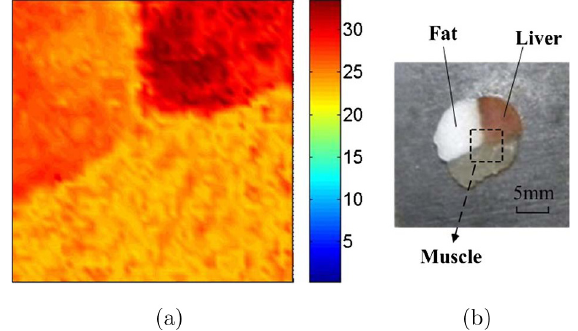
Source : Reproduced with permission from Ref. 42. Fig. 4. (a) PAVE imaging of sample. (b) Photograph of sample; the dashed frame is the PA scanning area.